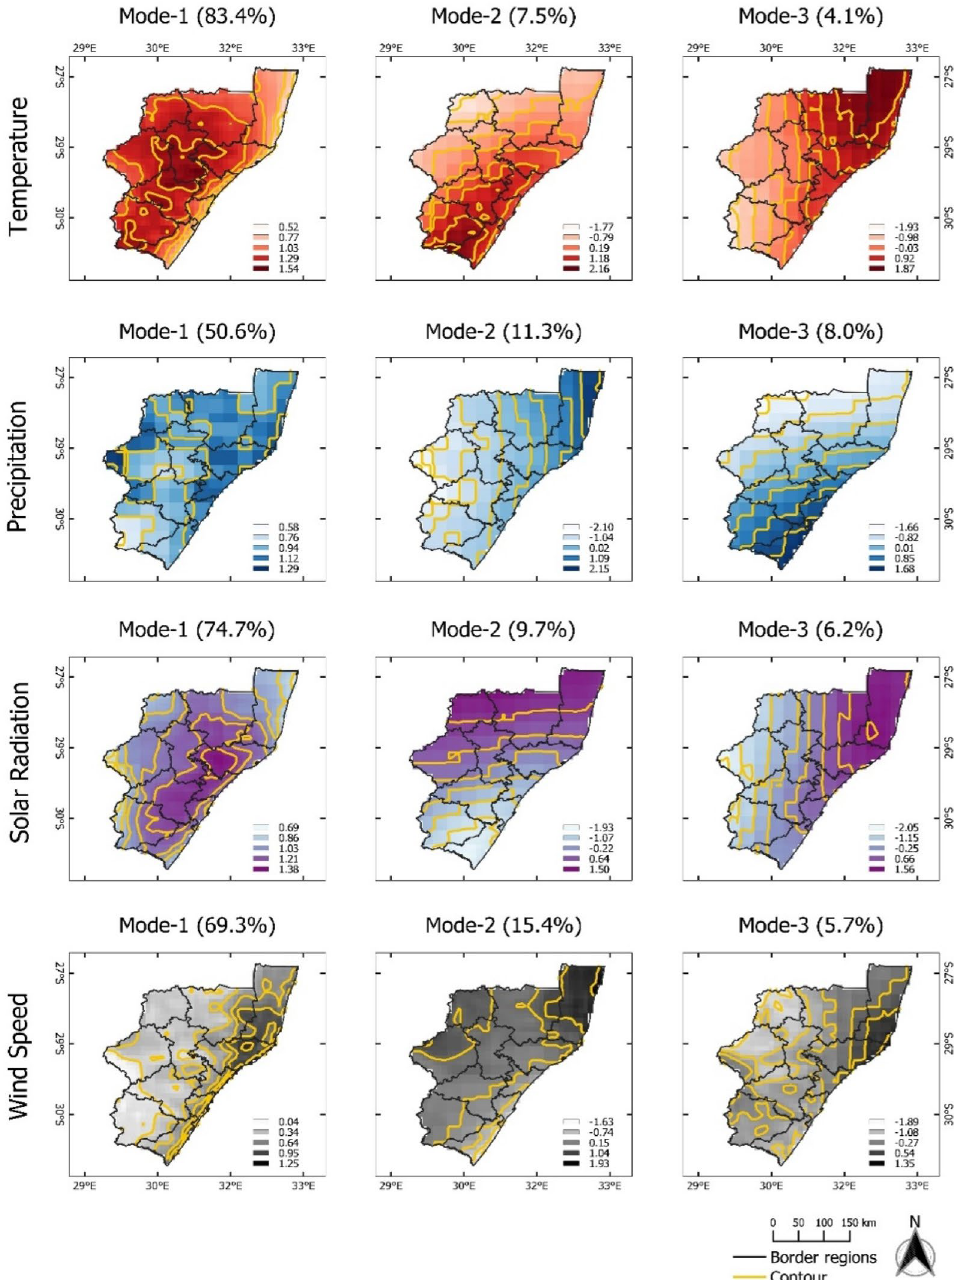
Figure 4. Map pattern of factor loadings for the first three modes (columns) derived from an EOF analysis for annual temperature, precipitation, solar radiation, and wind speed anomalies (rows) observed in the KwaZulu- Natal during the maize growing season of 1990/91–2020/21. Data for the maize growing season was used (cf. “Research data” section). Contour as for Fig.